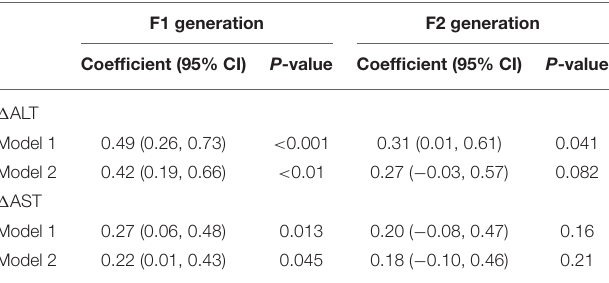
TABLE 4 | Associations with famine exposure and parental and offspring 1 alanine aminotransferase ( 1 ALT) and 1 aspartate aminotransferase ( 1 AST) in adulthood.